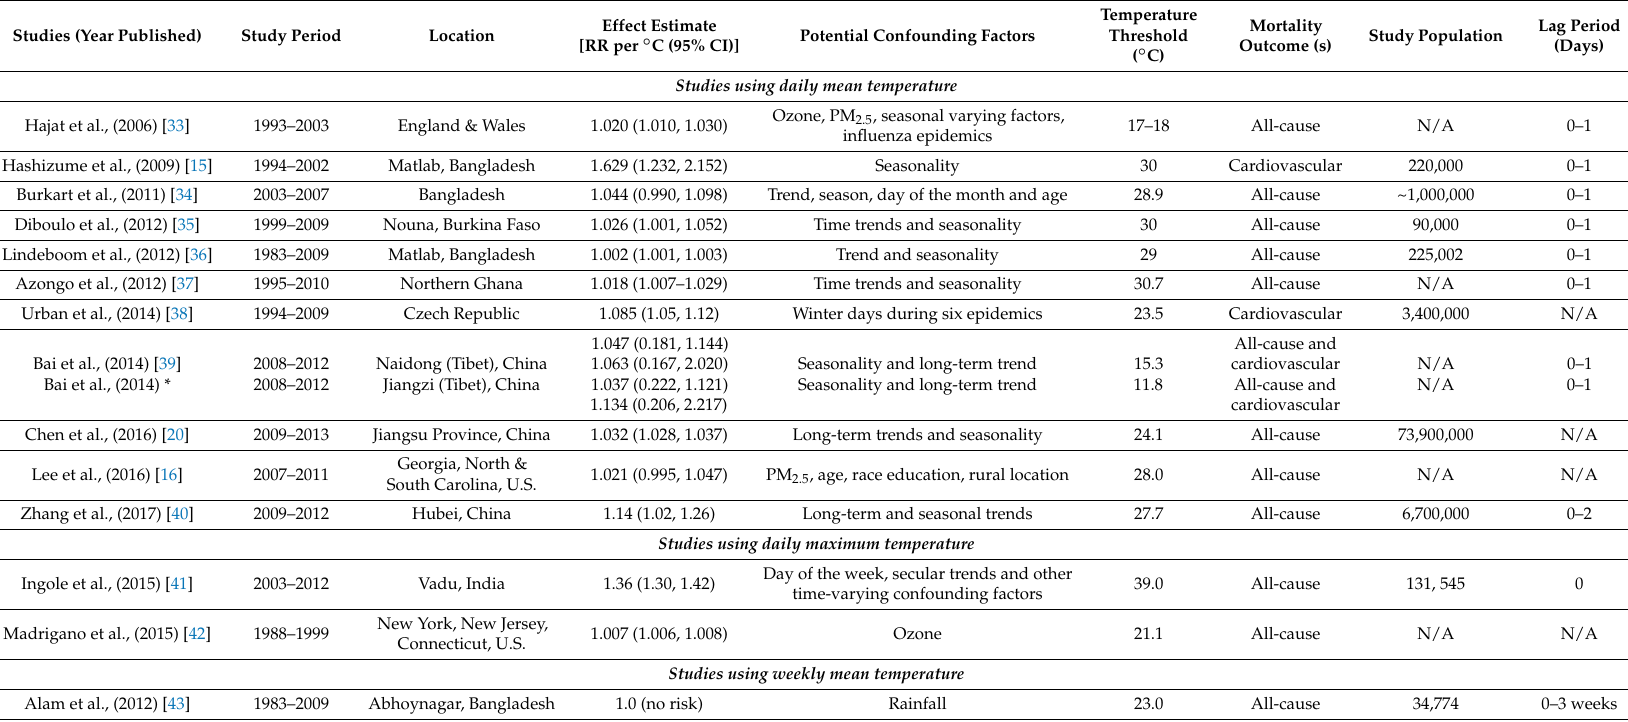
Table 1. Characteristics of selected studies that examined temperature effects on all-cause and cause-specific